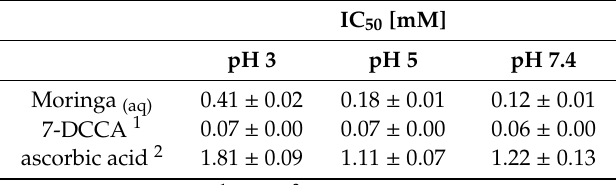
Table 1. IC 50 value of NaOCl concentration required to quench fluorescence of 150 µ M of 7-DCCA by 50% with or without the presence of compounds with potential anti-hypochlorite activity. Results obtained after 15 minutes of analytes incubation with an increasing concentration of NaOCl at 25 ◦